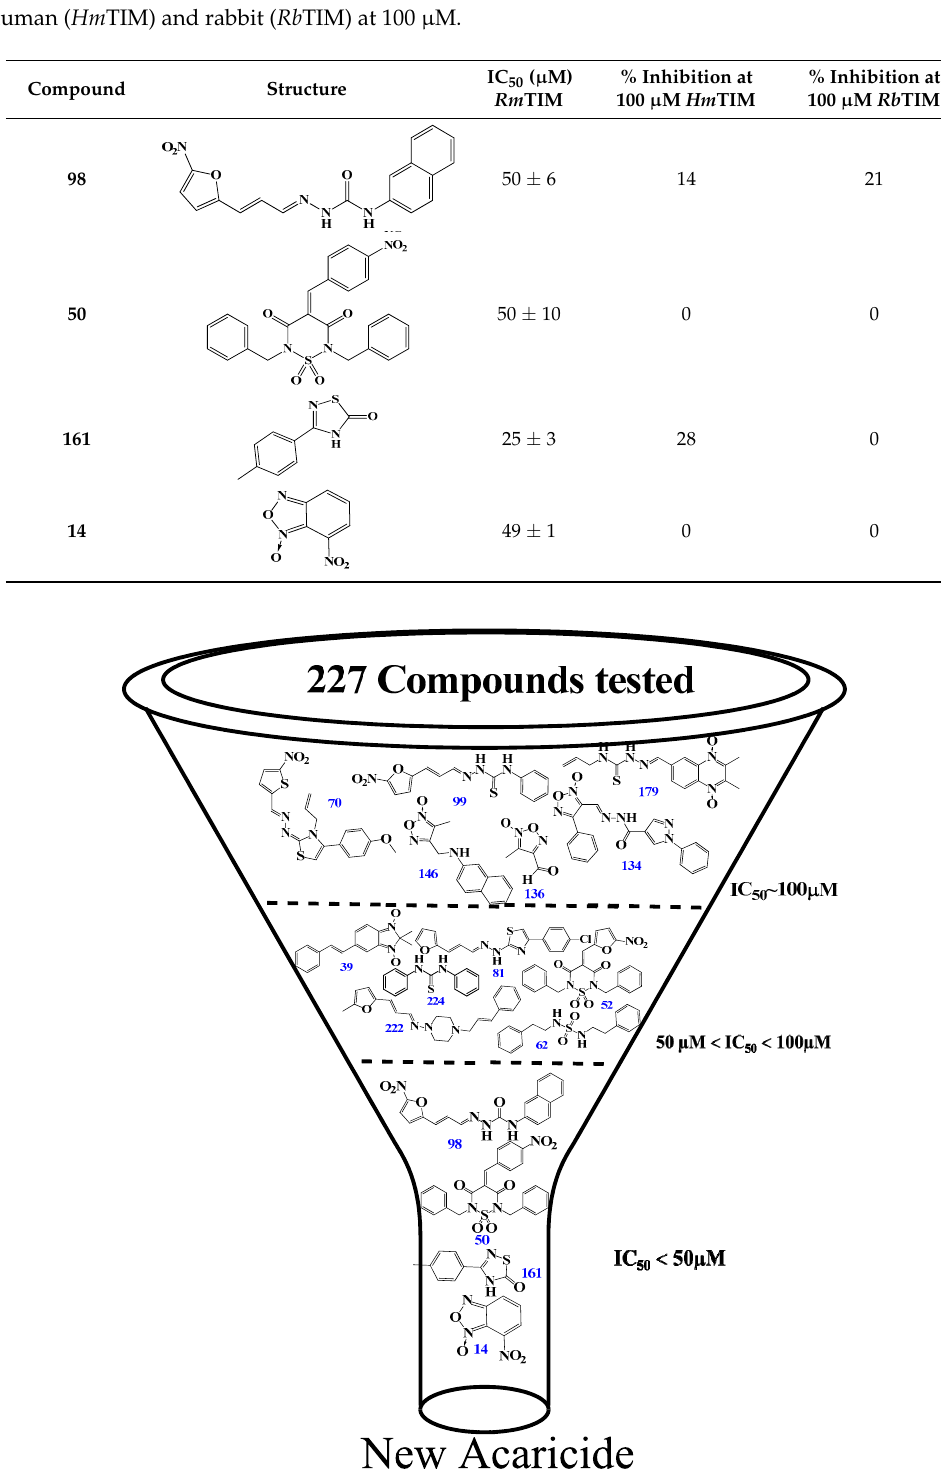
Table 1. IC 50 values of the most active compounds against Rm TIM and percentages of inhibition for human ( Hm TIM) and rabbit ( Rb TIM) at 100 μ M.